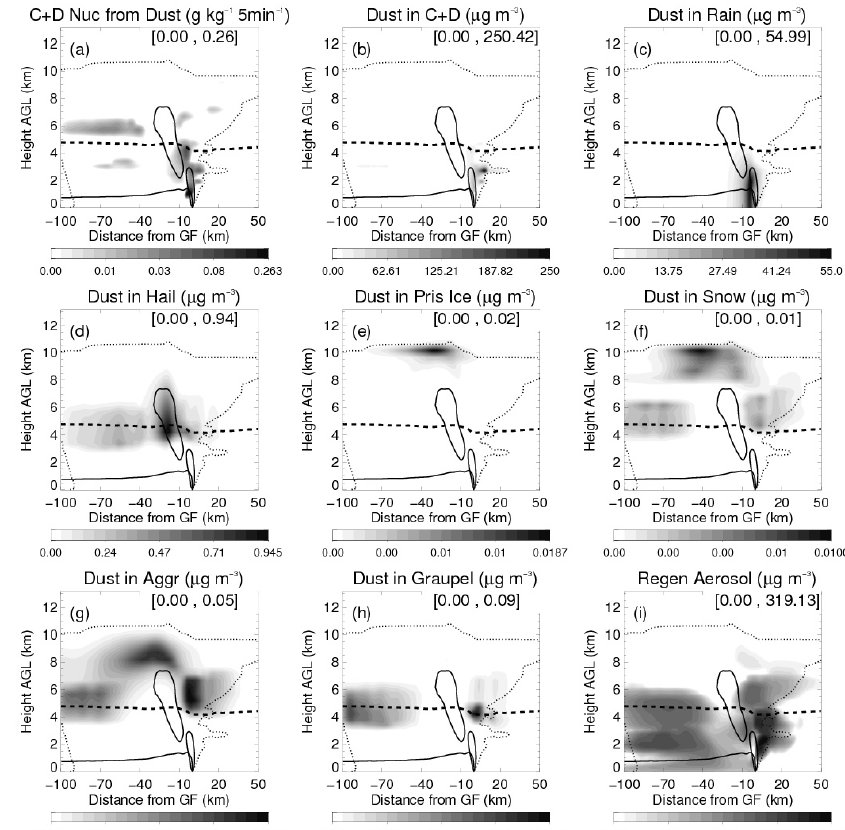
Fig. 8. The dOnrOn squall line, which has been averaged both meridionally along the gust front (GF) and temporally from sensitivity simulation hours 1–5. Each vertical cross section is expressed as a horizontal distance from the gust front (x-axis) and a vertical distance a.g.l. (y-axis). Shown on each cross section is the squall line cloud boundary (dotted line; 0.05 g kg − 1 total condensate), the freezing line (dashed black line), the cold pool boundary (thin black line below 2kma.g.l.; − 0.05 m 2 s − 2 following Tompkins (2001)), the 1ms − 1 updraft region (thick black lines stemming from the gust front), and (min, max) values for the shaded quantities of the following: (a) cloud and drizzle (C + D) nucleation rate by dust; (b) dust within C + D; (c) dust within rain; (d) dust within hail; (e) dust within pristine ice; (f) dust within snow; (g) dust within aggregates; (h) dust within graupel; and (i) concentration of regeneration aerosol. The units are shown in the figure for each